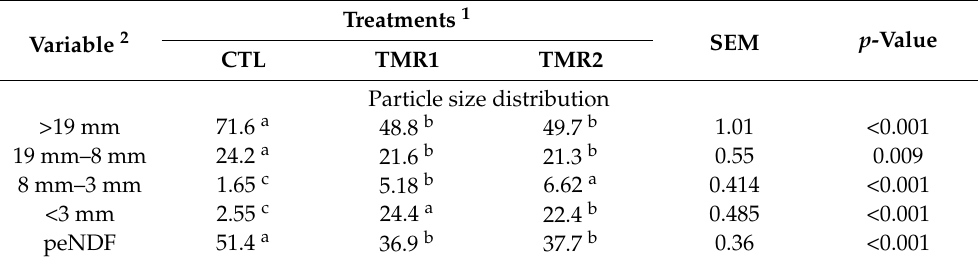
Table 3. Particle size distribution (%) of the diets offered to